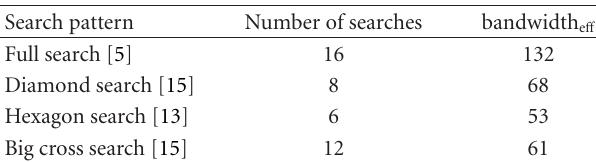
Table 3: E ff ective bandwidth (in terms of number of pixels per clock cycle) provided by the proposed 2D